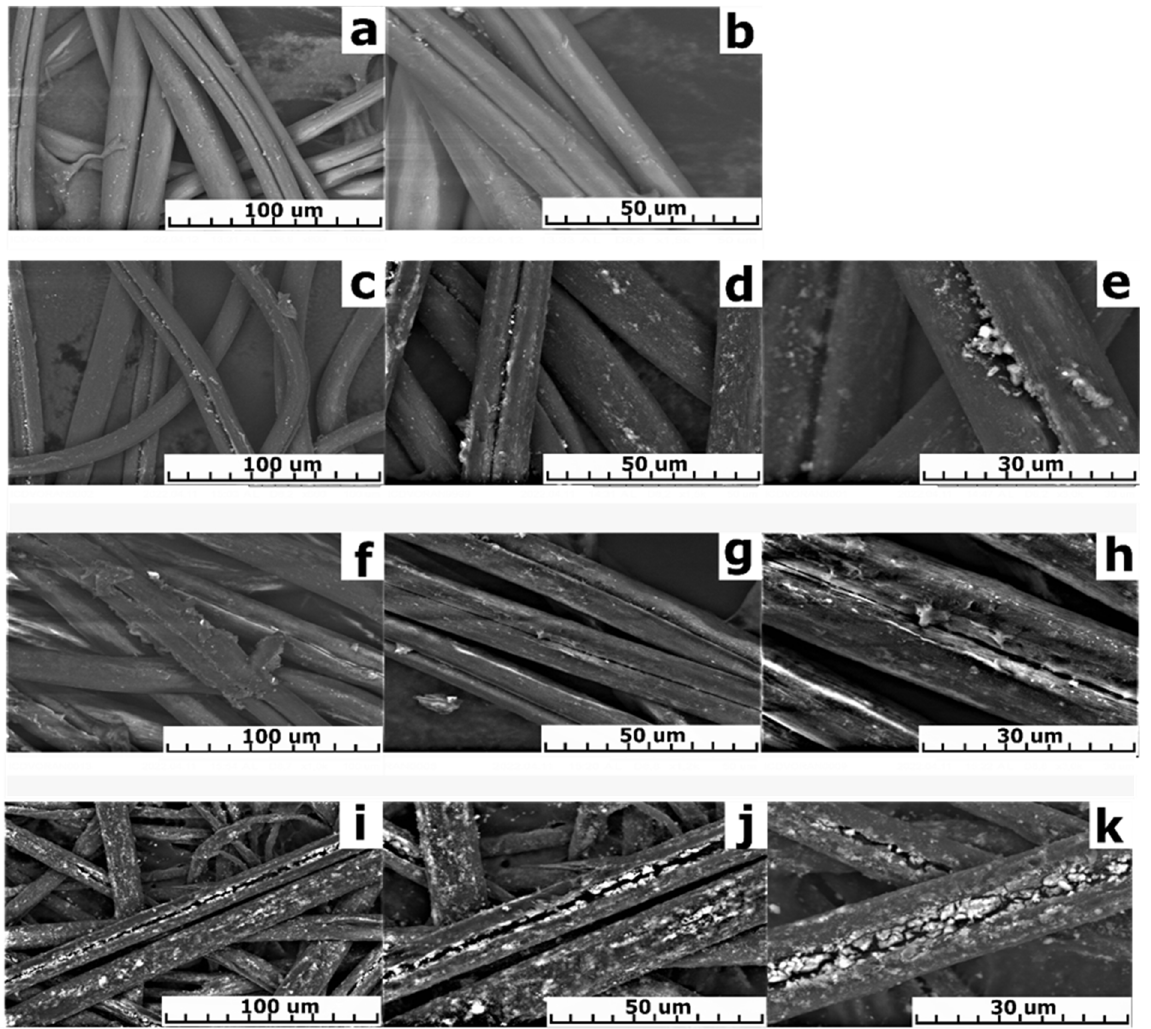
Figure 8. SEM images: ( a , b )—PAN; ( c – e )—Fe-SF; ( f – h )—Fe-NH; ( i – k )—Fe-H (100–50–30 microns).